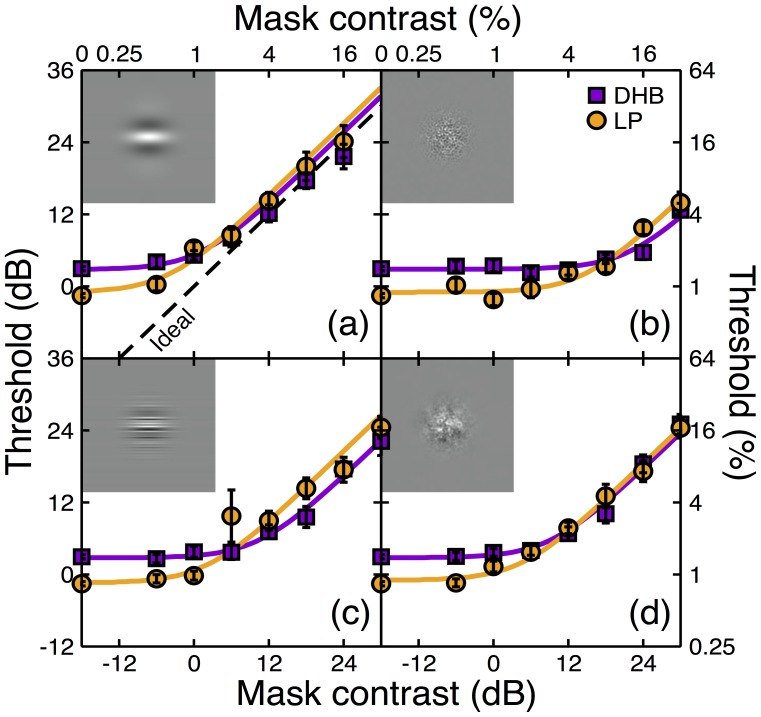
Noise masking functions for two observers and four varieties of external noise.Insets to each panel show examples of the noise stimuli. (a) 0D noise, (b) 2D white noise, (c) 1D white noise, (d) 2D pink noise. The 0D noise had the same spatial waveform as the target. Error bars show standard deviations of a population of bootstrap resamples. The curves are fits of a noisy linear observer model detailed in the text, that had two free parameters per curve. The oblique dashed line in panel (a) gives the prediction of the ideal observer.